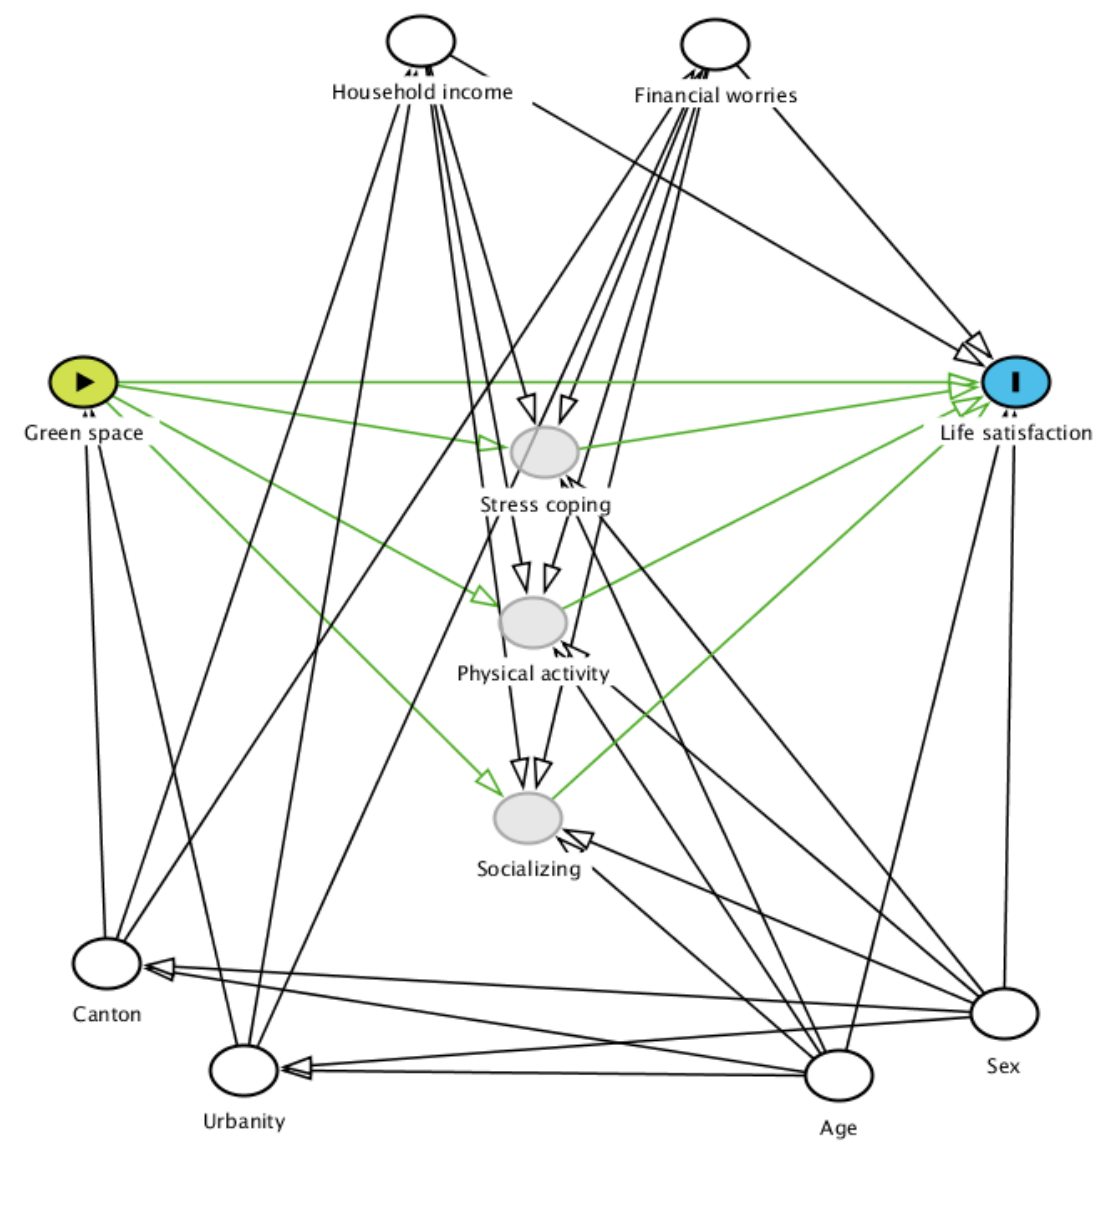
Figure S1. Hypothesized pathways that potentially link green space to life